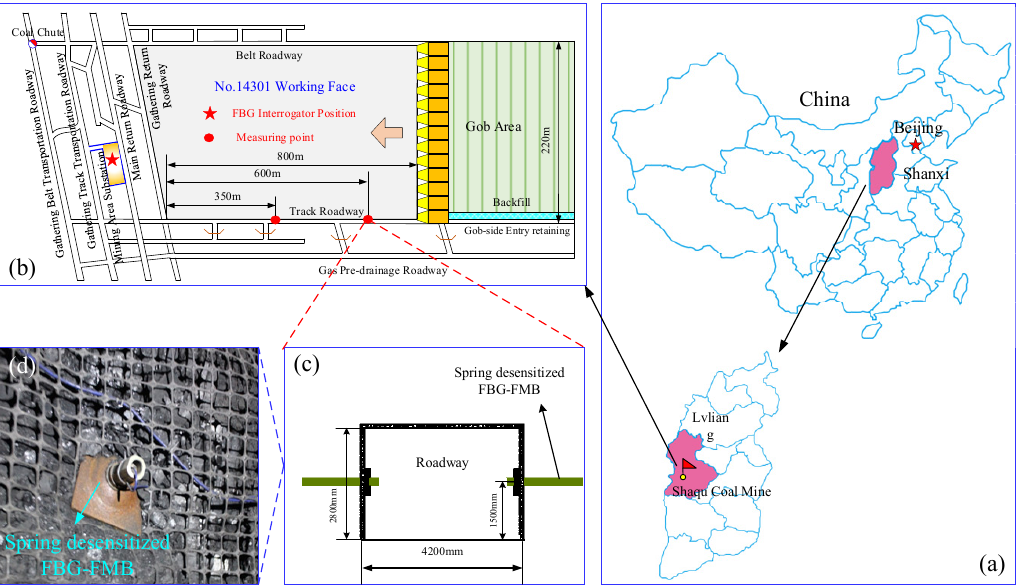
Figure 11. The location of No.14301 working face and bolt arrangements in Shaqu Mine. ( a ) Location of Shaqu Coal Mine; ( b ) plan view of No.14301 working face; ( c ) layout position of bolts; ( d ) photo of bolt arrangement in roadway.